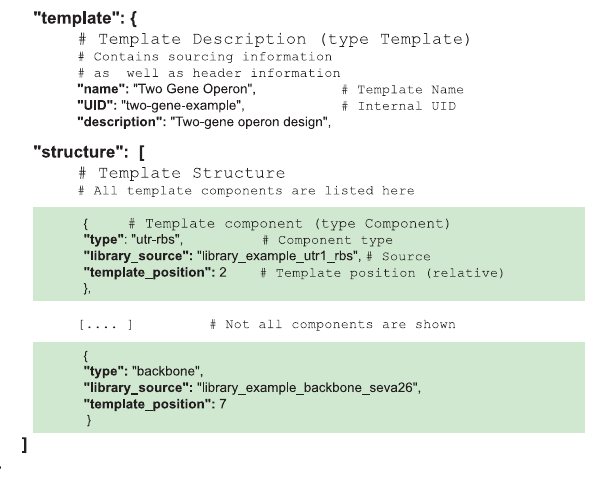
C Template ( Figure 3A ): The construct has 6 components (1 promoter, 2 RBS, 2 CDS and a terminator) arranged in an operon pattern. C Combinatorics ( Figure 3B ): A promoter library of 5, 2 RBS libraries of 10, 2 CDS libraries of 1 and a Terminator library of 1 are used.